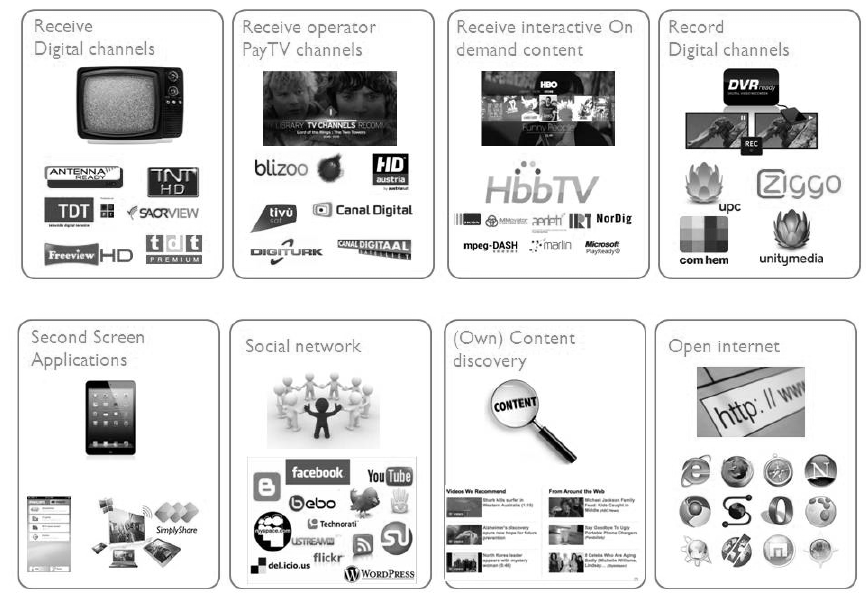
Fig. 1. The experience ecosystem of a TV. In the first line the more traditional use cases can be found. They show content which is also available via linear broadcast. In the second line the new interactive use cases together with examples of the ecosystem are